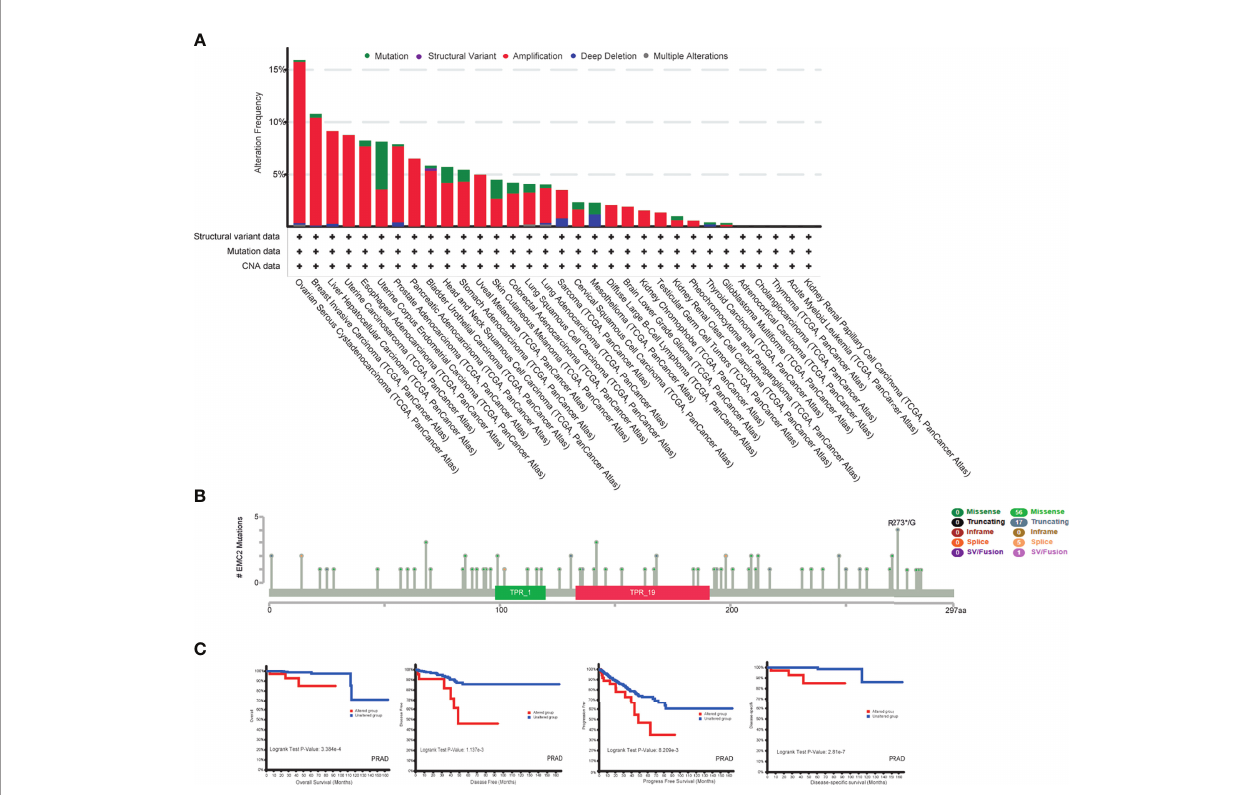
FIGURE 3 | Mutation feature of EMC2 in different tumors of TCGA. (A) We analyzed the mutation features of EMC2 for the TCGA tumors using the cBioPortal tool. (B) We also analyzed the potential correlation between mutation status and overall, disease-speci fi c, disease-free and progression-free survival of LIHC (C) using the cBioPortal tool.